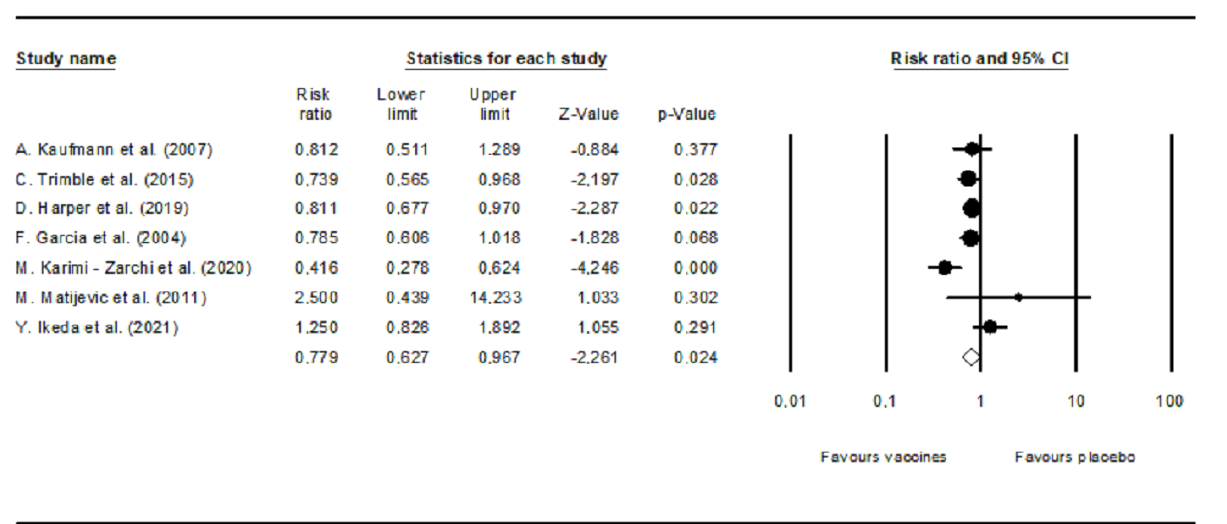
Figure 5. Forest plot of vaccines’ efficacy against high-grade cervical intraepithelial neoplasia (CIN 2/3) in women compared with placebo. Data were obtained by the presence of CIN2/3 confirmed cases in vaccinated group versus unvaccinated group.